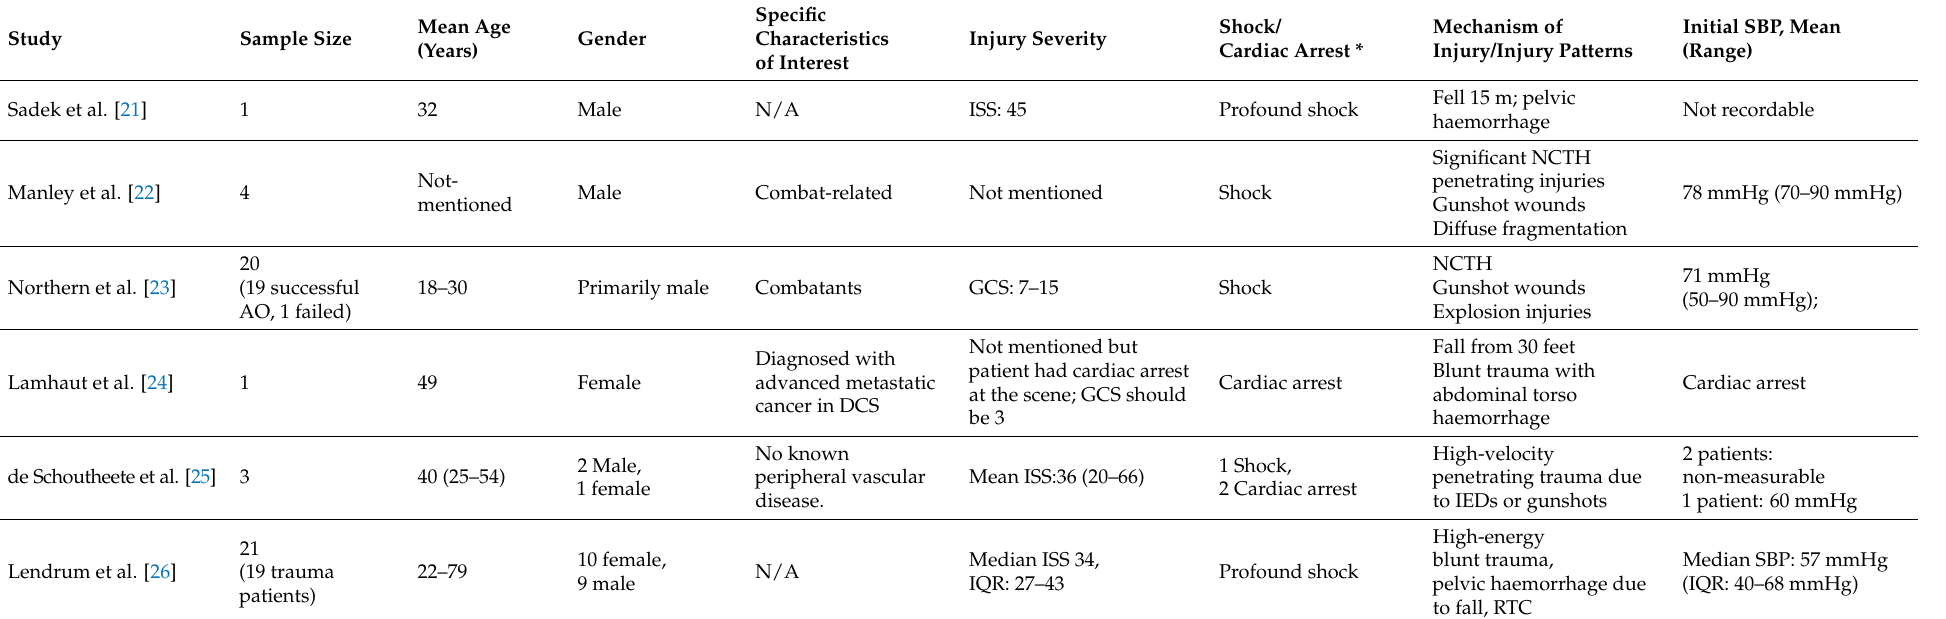
Table 4. Patients’ characteristics of included